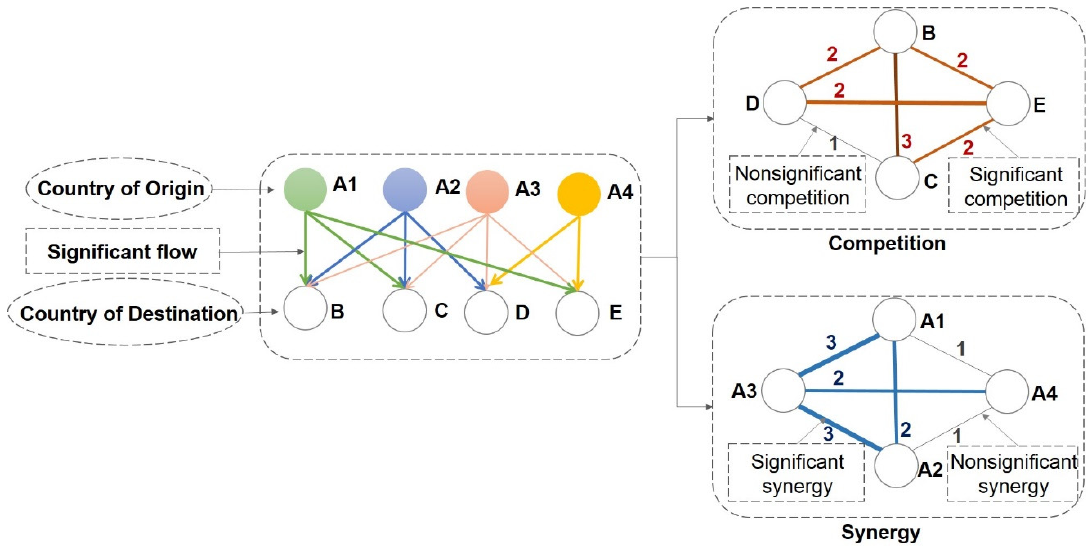
Figure 4. Competition–synergy model based on multiple linkage theory. Source: Adapted from Li et al. [50]. Table 1. Significant flow movement pattern and its influence on network relations.